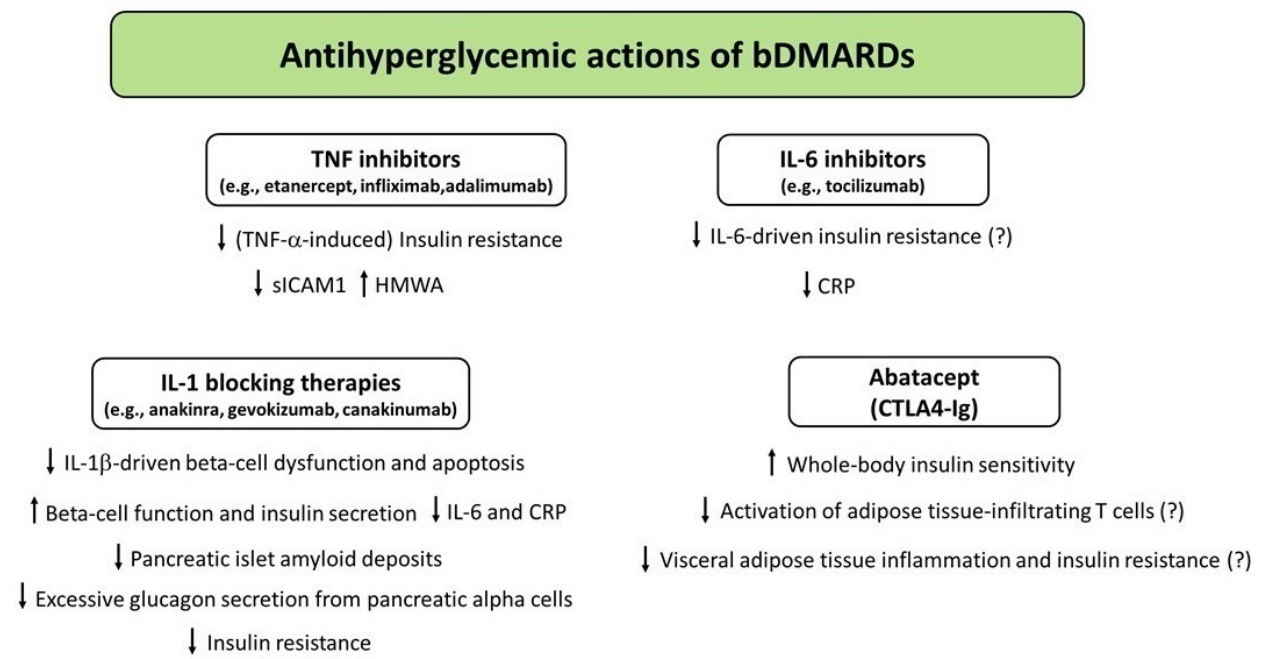
Figure 3. Potential mechanisms underlying the antihyperglycemic actions exerted by biologic DMARDs (bDMARDs). Abbreviations: CRP, C-reactive protein; DMARDs, disease-modifying antirheumatic drugs; HMWA, high-molecular weight adiponectin; IL, interleukin; sICAM-1, soluble intercellular adhesion molecule-1; TNF- α, tumor necrosis factor α.